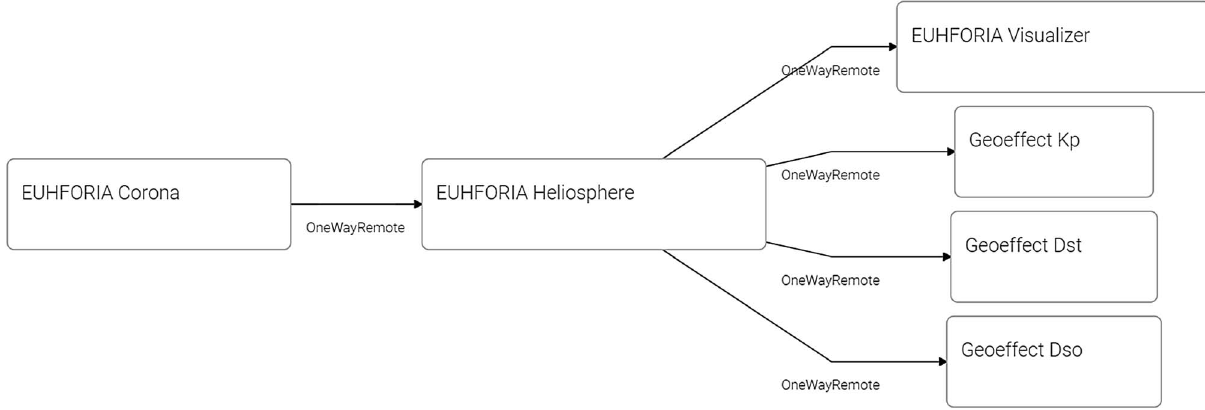
Fig. 11. EUHFORIA coupled to the geo-effect indices